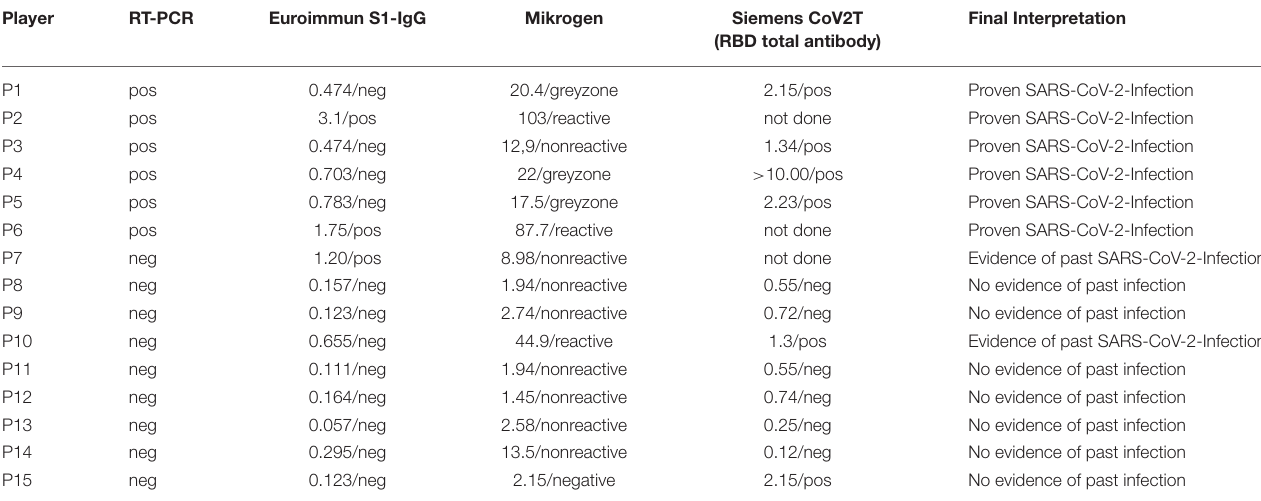
TABLE 1 | Summary of RT-PCR and serological testing.